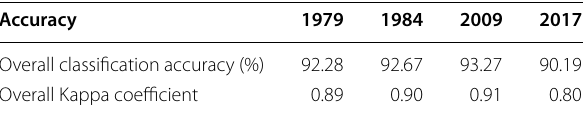
Table 2 Accuracy assessment of the land use/land cover classification for the study